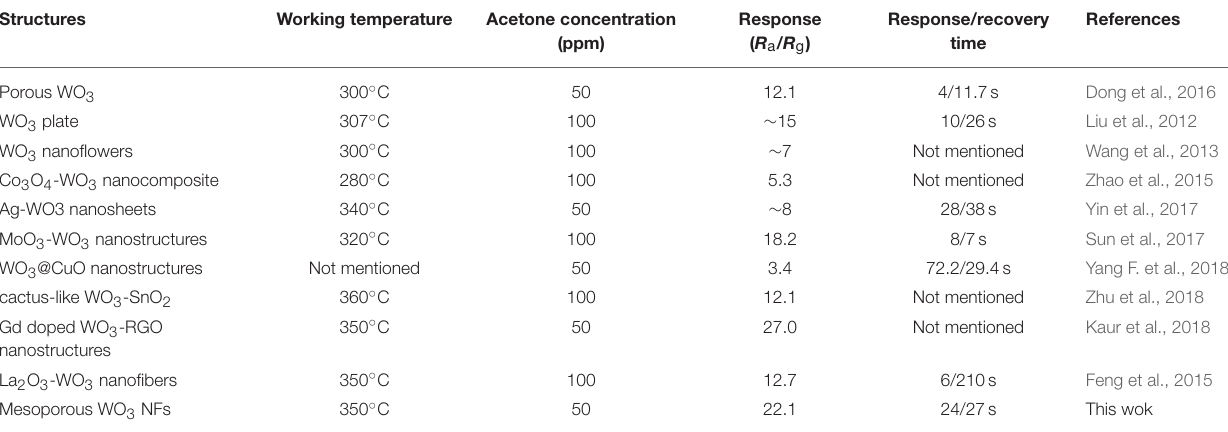
TABLE 1 | Comparison of acetone sensing properties of WO 3 or WO 3 based sensors with various nanostructures.